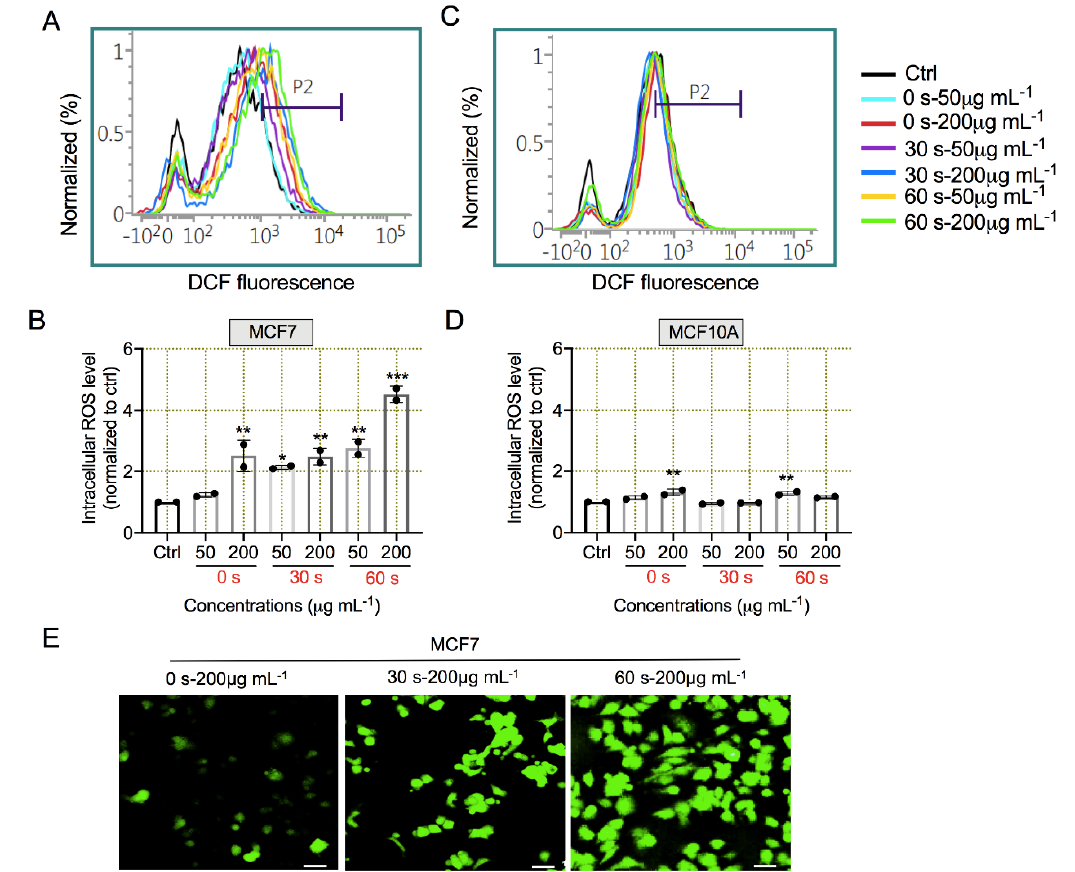
Figure 7. Plasma-treated mushroom-derived extracts induced intracellular oxidative stress. ( A – D ) Flow cytometric detection of intracellular ROS in MCF7 breast cancer and MCF10A normal cells treated with extracts prepared from 0 s (untreated), 30 and 60 s plasma-treated (0 s) mushrooms, after 24 h post-incubation at 50 and 200 µg mL −1 using fluorescent H2DCFDA dye, respectively; ( E ) Microscopic images of ROS detection in MCF7 cells treated in similar conditions as above. Untreated sample (no extract) was used as control for normalization. * p < 0.05, ** p < 0.01, and *** p < 0.001.